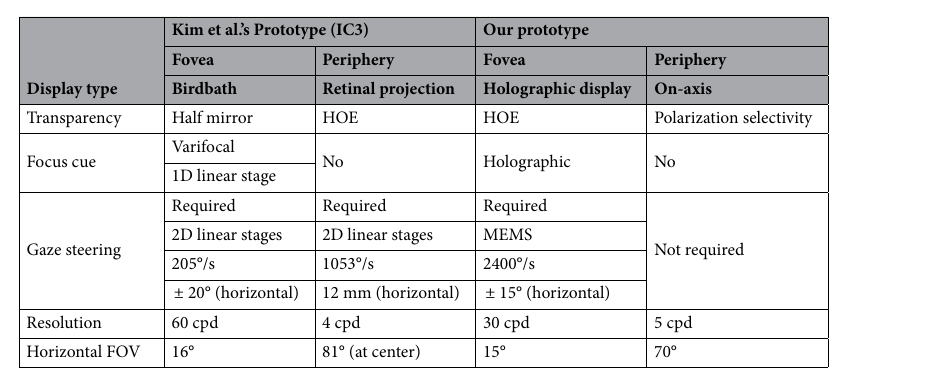
Table 1. Comparison of our prototype with the related work presented by Kim et al. 3 .